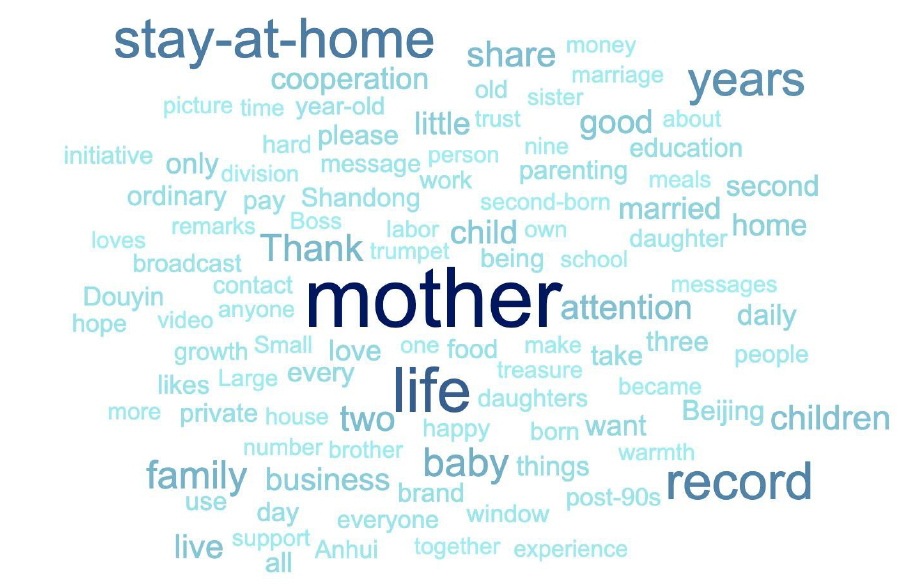
Figure 3. Word cloud of mother vlogger’s